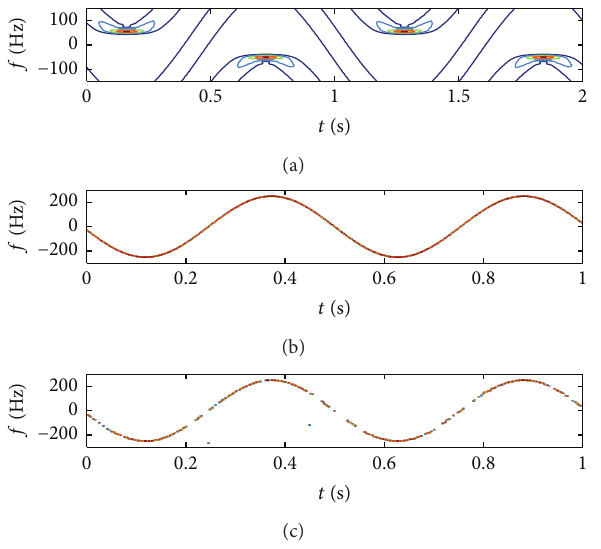
Figure 4: CS reconstruction quality with different measurement number. (a) 𝑀 = 10; (b) 𝑀 = 6.